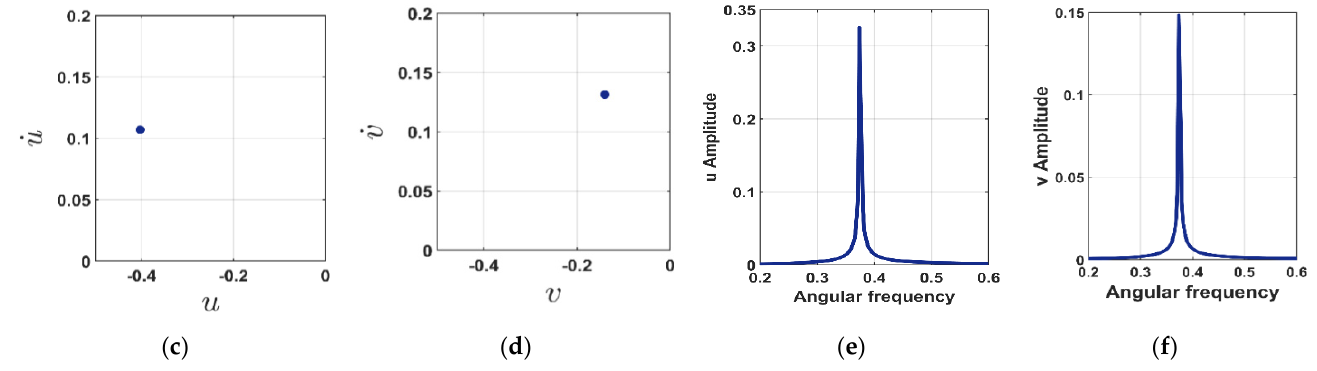
Figure 8. Periodic time-response, Poincaré-map, and frequency-spectrum of the controlled Jeffcott-rotor according to Figure 7 (i.e., at σ = 0, δ 1 = 0.83, δ 2 = 0.002) when E = 0.02: ( a , b ) the normalized temporal oscillations 𝑢(𝑡) and 𝑣(𝑡) in 𝑋 and 𝑌 direction, ( c , d ) the corresponding Poincaré-map, ( e , f ) the corresponding frequency-spectrum.